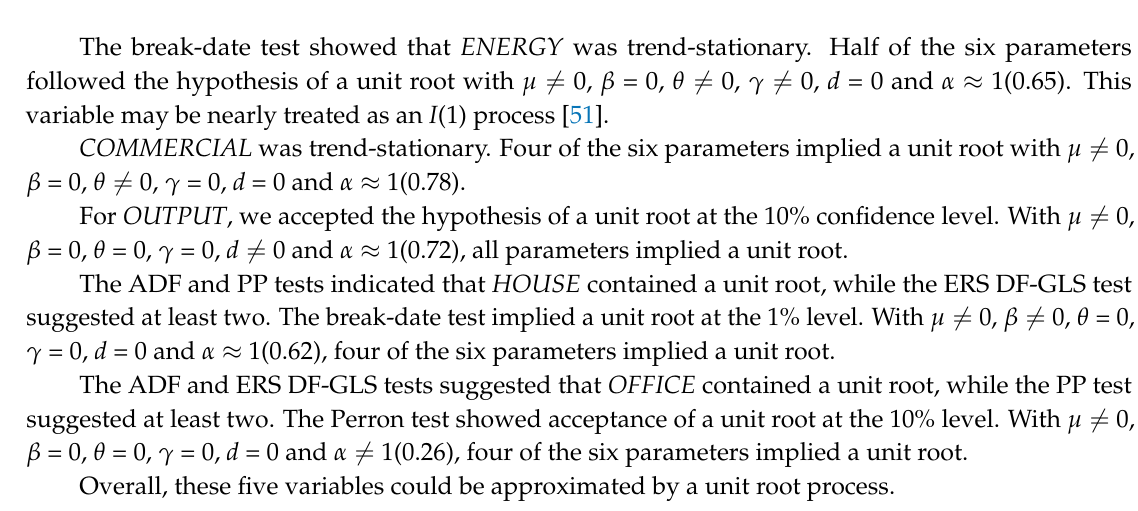
Table 2. The unit root tests.